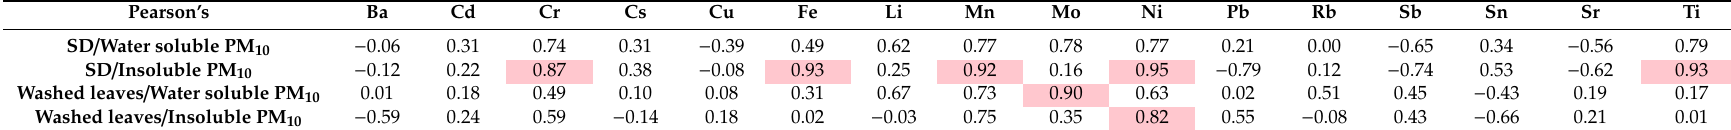
Table 2. Pearson’s correlation coe ffi cients calculated between SD and washed leaves element concentrations and their concentrations in the water-soluble and -insoluble fractions of PM 10 : Mean monthly concentrations at each site were included in the elaboration (N = 30). Positive linear correlations (Pearson’s coe ffi cient > 0.8) between the two variables are reported in red.